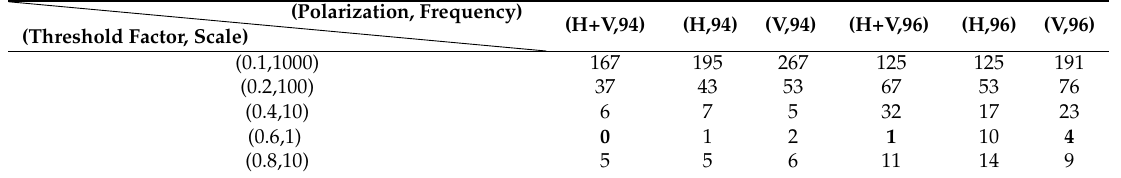
Table 2. Number of missclassified images for various conditions for the acquisition and the procecessing of the radar